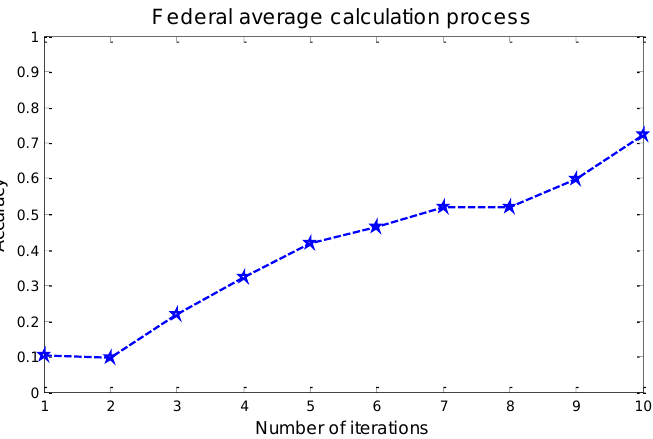
Figure 6. Accuracy variation diagram of 10 iterations.